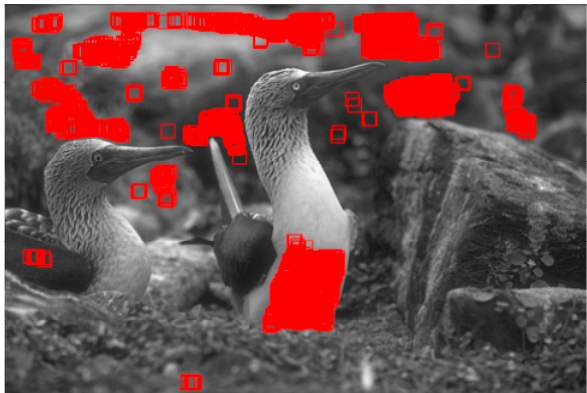
Figure 5. An example for homogenous blocks selection, and those 15 × 15 red boxes in the “Birds” image have outlined the finally selected homogenous blocks.